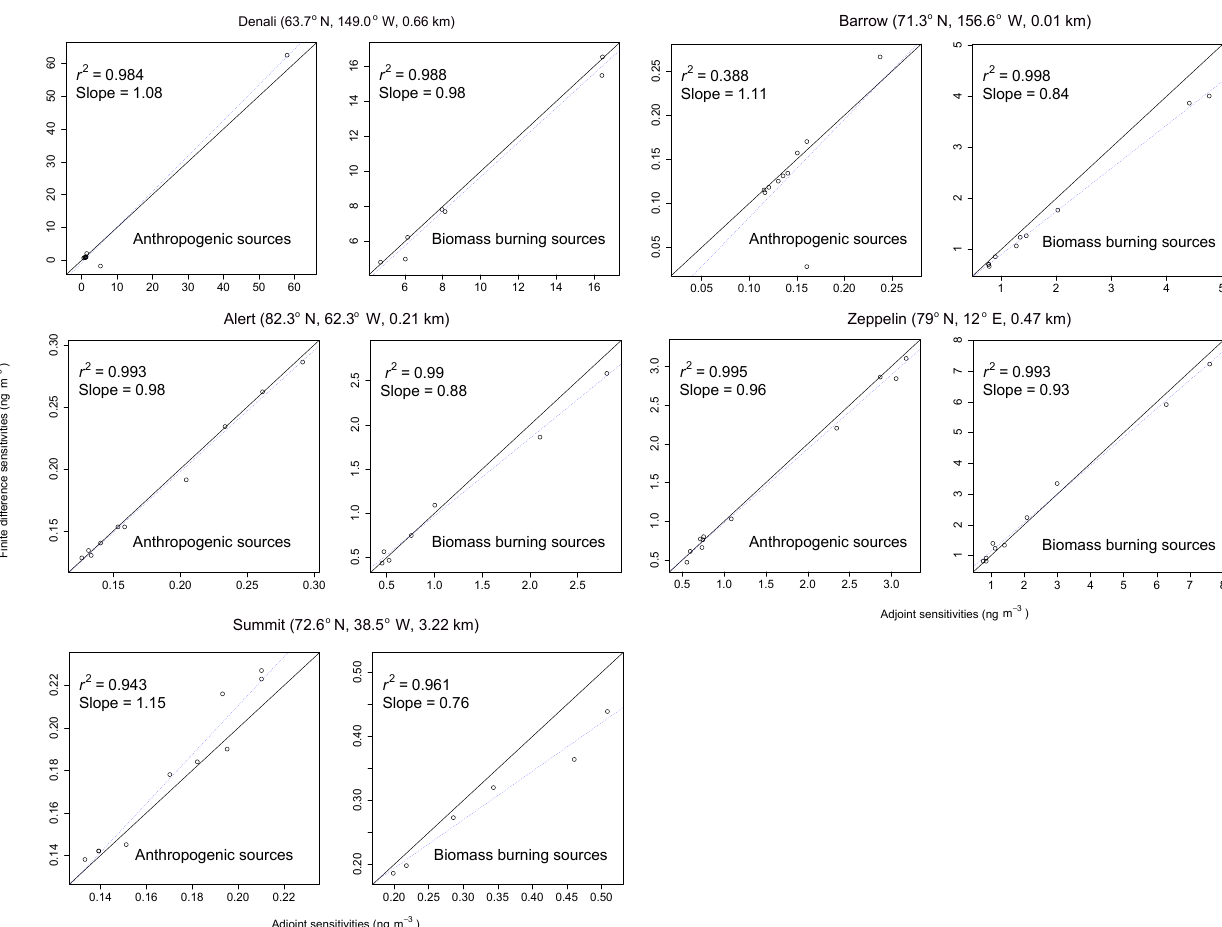
Figure 3. GEOS-Chem adjoint versus finite difference gradients of BC concentration for 10 model grid cells with largest anthropogenic BC contributions and 10 grid cells with largest biomass burning BC contributions at Denali, Barrow, Alert, Zeppelin, and Summit (see Fig. 1). Values are for 1 March–25 April 2008. Regression lines, slopes, and r 2 values are